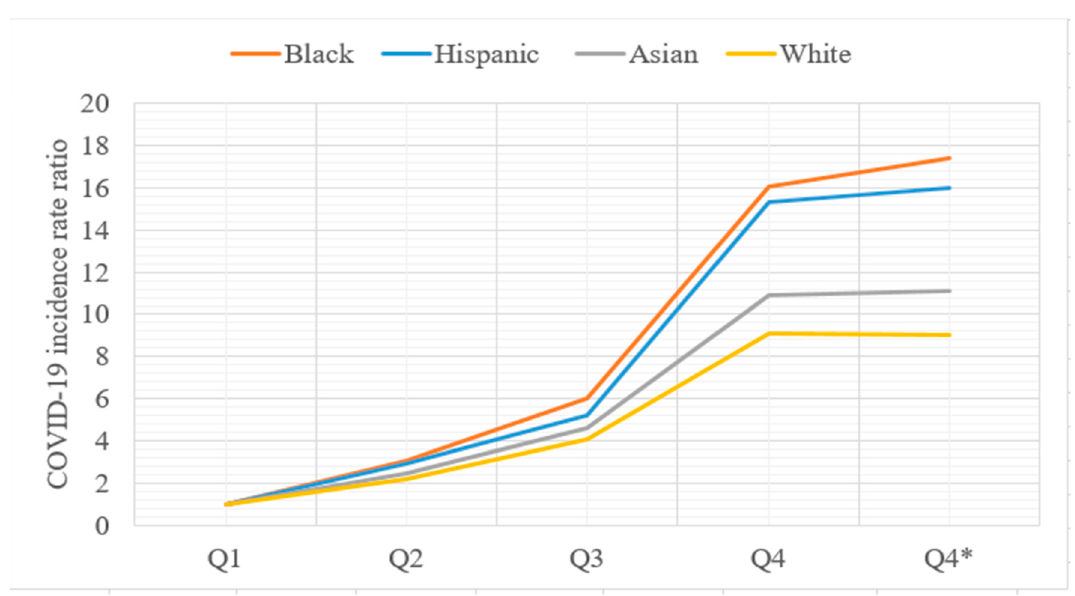
Figure 2. Variation of COVID-19 incidence rate across racial population in city/town, M.A. The COVID-19 incidence rate ratio represents the ratio of the COVID-19 incidence rate in each quantile compared to the first quantile.